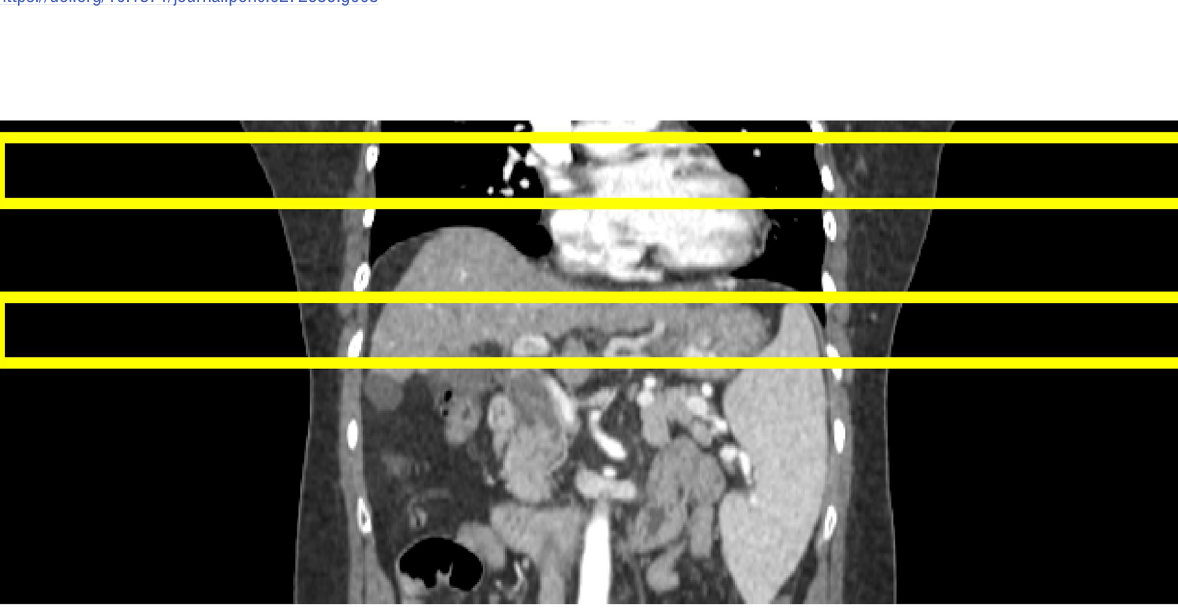
PLOS ONE | https://doi.org/10.1371/journal.pone.0272639 August 26, 2022 6 /